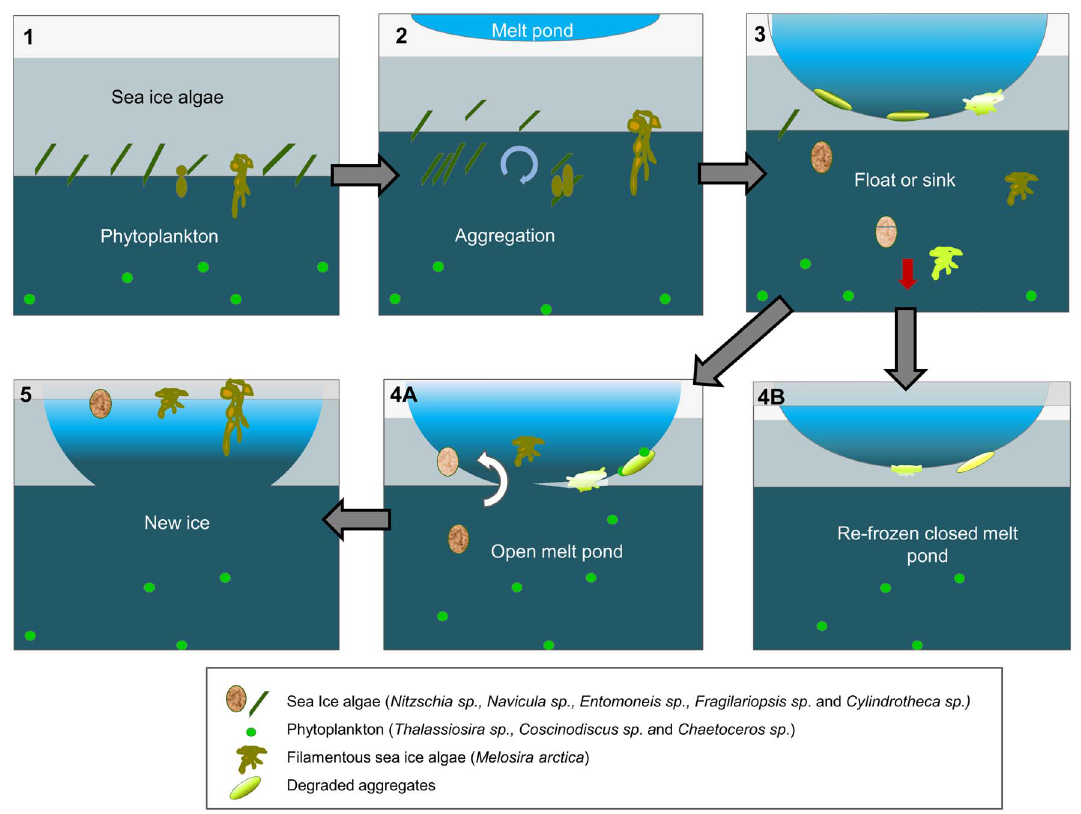
Figure 6. Conceptual model of the mechanisms responsible for the formation and fate of the different types of algal aggregates. (1) In early spring sea-ice algal growth starts before that of phytoplankton. (2) In summer as the sea ice melts and nutrients become limiting, some sea- ice algae are released to the water column or grow into the water column. Due to their stickiness and the under-ice turbulence they form aggregates. (3) In late summer melt ponds grow in depth and the sea-ice algae that are still in the ice are gradually exposed to very low salinities, high irradiances, and nutrient depletion making them accumulate and degrade in the pond. Depending on the environmental conditions, some sub-ice aggregates sink and others remain floating. (4) In early autumn, the melt ponds can either open completely allowing some phytoplankton species to come into the melt pond, or they can refreeze again, becoming second year ice. (5) In autumn those melt ponds that were open to the seawater freeze again, trapping the floating aggregates that were not grazed in the newly formed ice.